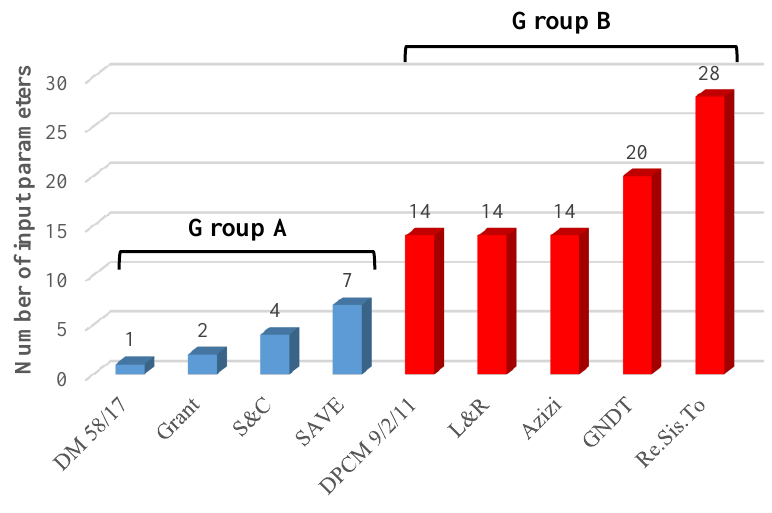
Figure 1. Input parameters for fast vulnerability assessment methods.